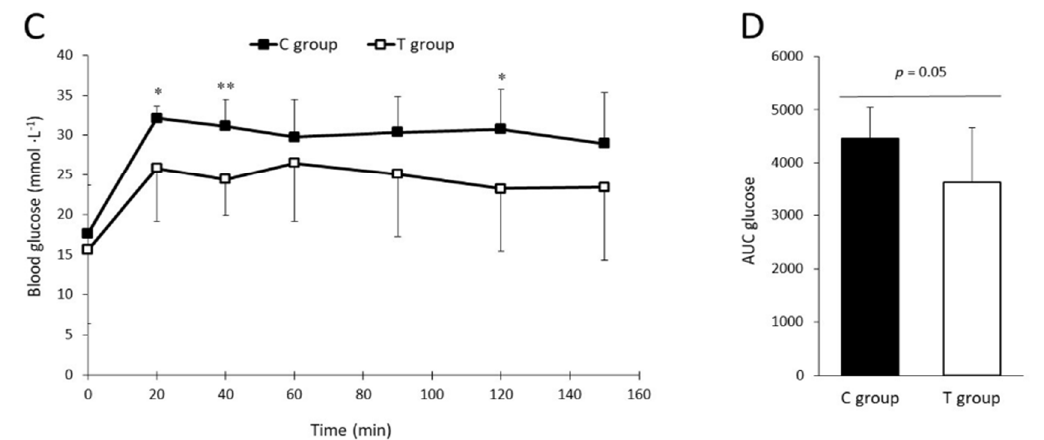
Figure 1. E ff ect of the fermented food product (FFP) on glucose metabolism. ( A ) Weekly fasting blood glucose (FBG) progression in Zucker diabetic fatty (ZDF) rats. Animals in T group showed lower FBG mean values than animals in C group during the study. Statistically significant di ff erences were found at 4, 6, 14, 16, 21, 22, 24, 27, 28, and 31 weeks ( p = 0.004, p = 0.038, p = 0.013, p = 0.013, p = 0.005, p = 0.026, p = 0.001, p = 0.030, p = 0.001, and p = 0.016, respectively). ( B ) Bar plots represent basal and end point FBG values in the groups. No statistical significant di ff erences were found between basal and end point FBG values in any groups (7.2 ± 1.3 versus 19.5 ± 6.3 mmol L − 1 at 0 and 31 weeks, respectively in C group; 7.6 ± 1.8 versus 8.2 ± 1.6 mmol L − 1 at 0 and 31 weeks respectively in T group). ( C ) Two-months glucose tolerance test (GTT) curve. The GTT curve, after two months of FFP supplementation, showed lower blood glucose levels and statistically significant di ff erences between groups were found at 20, 40, and 120 min ( p = 0.034, p = 0.007, and p = 0.038, respectively). ( D ) Area under the curve (AUC) plot. The AUC value was lower in T group (3622.5 ± 1040.4) compared to C group (4454.0 ± 590.9) although the p value obtained was in the limit of significance ( p = 0.05). Values are expressed as mean ± SD. wk = week. * p < 0.05, ** p < 0.01.